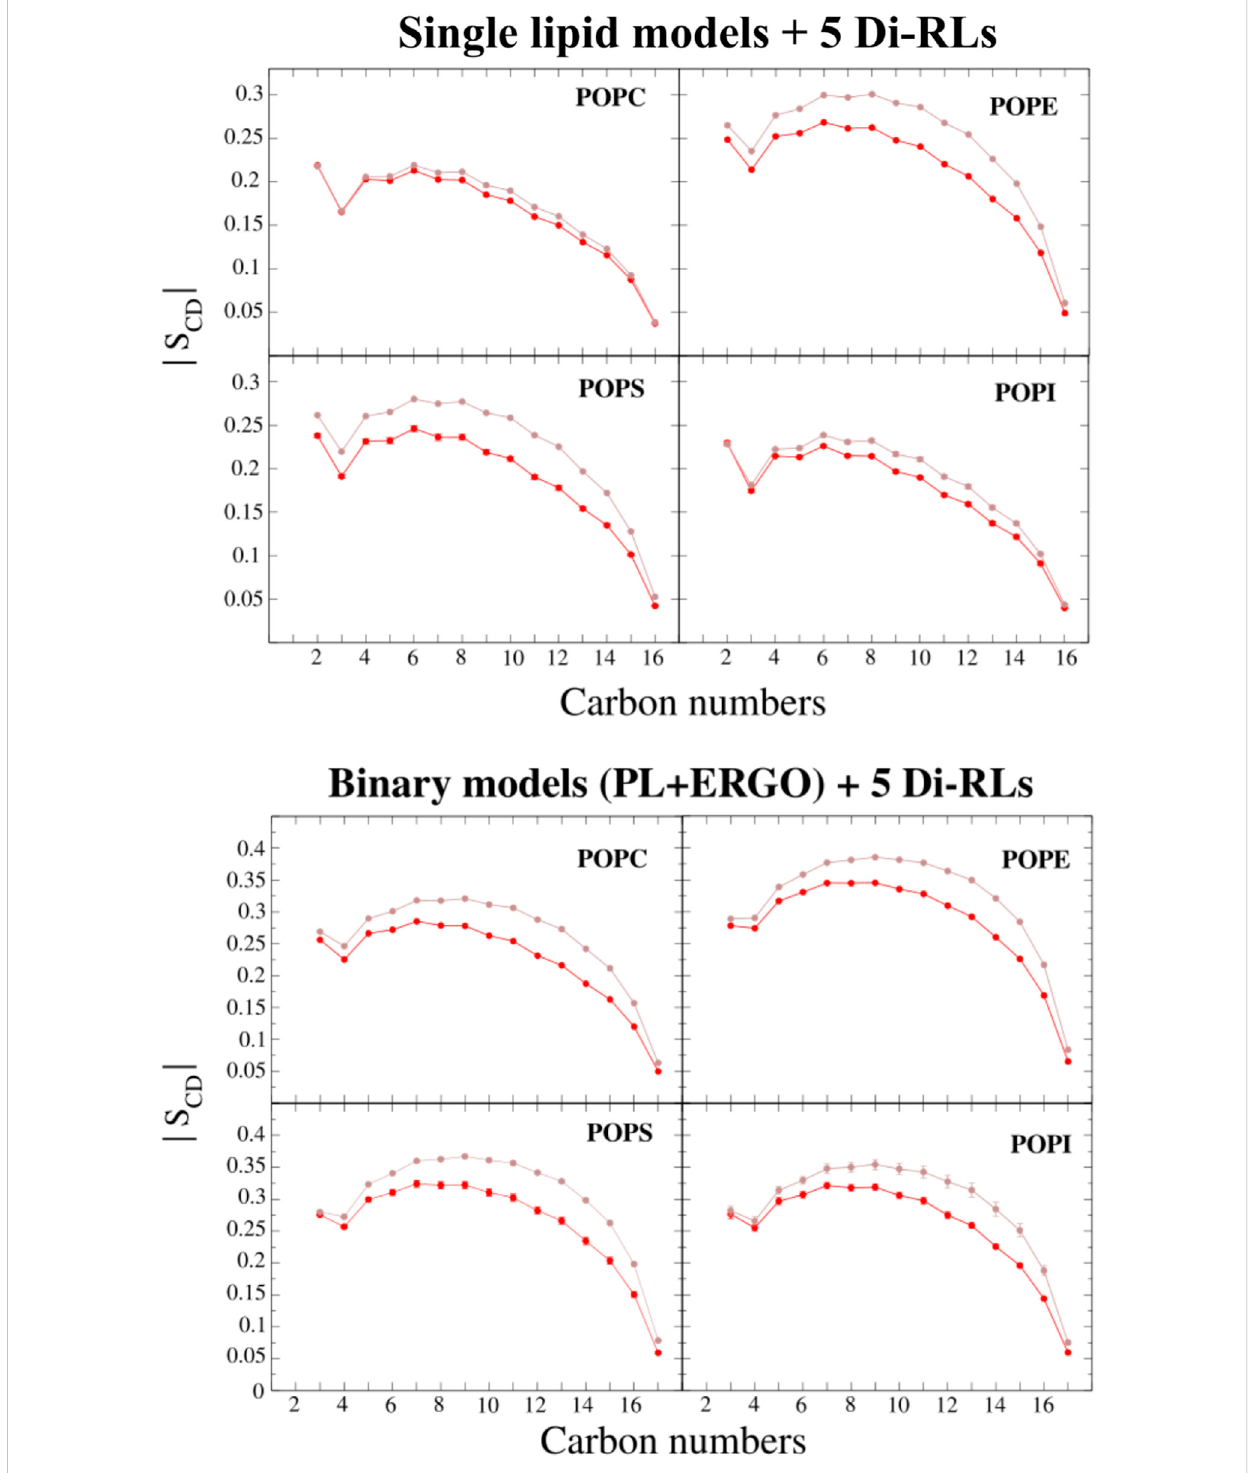
FIGURE 9 Thedeuteriumorderparameterscomparedwiththecarbonpositionofthesn-1acylchainofsingle-PLmembranemodels(POPC,POPE,POPSand POPI) and binary membrane models (POPC/ERGO, POPE/ERGO, POPS/ERGO and POPI/ERGO, 70/30 M ratios) with and without di-RLs (shown in red and brown, respectively). The error bars represent the standard deviation of the last averaged 250 ns (smaller than the symbol size in some cases).